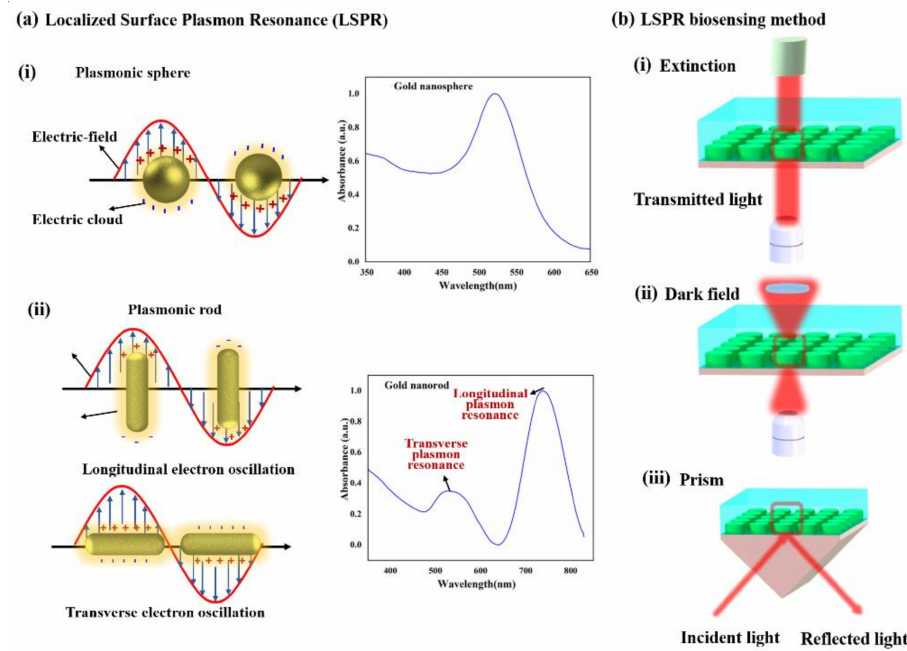
Figure 3. Schematic representations of ( a ) the localized surface plasmon resonance (LSPR) of ( i ) plasmonic nanosphere and ( ii ) plasmonic nanorod positioned in a static electric field. ( b ) LSPR biosensing methods, including ( i ) extinction, ( ii ) dark-field, and ( iii ) prism coupler on the plasmonic nanostructured